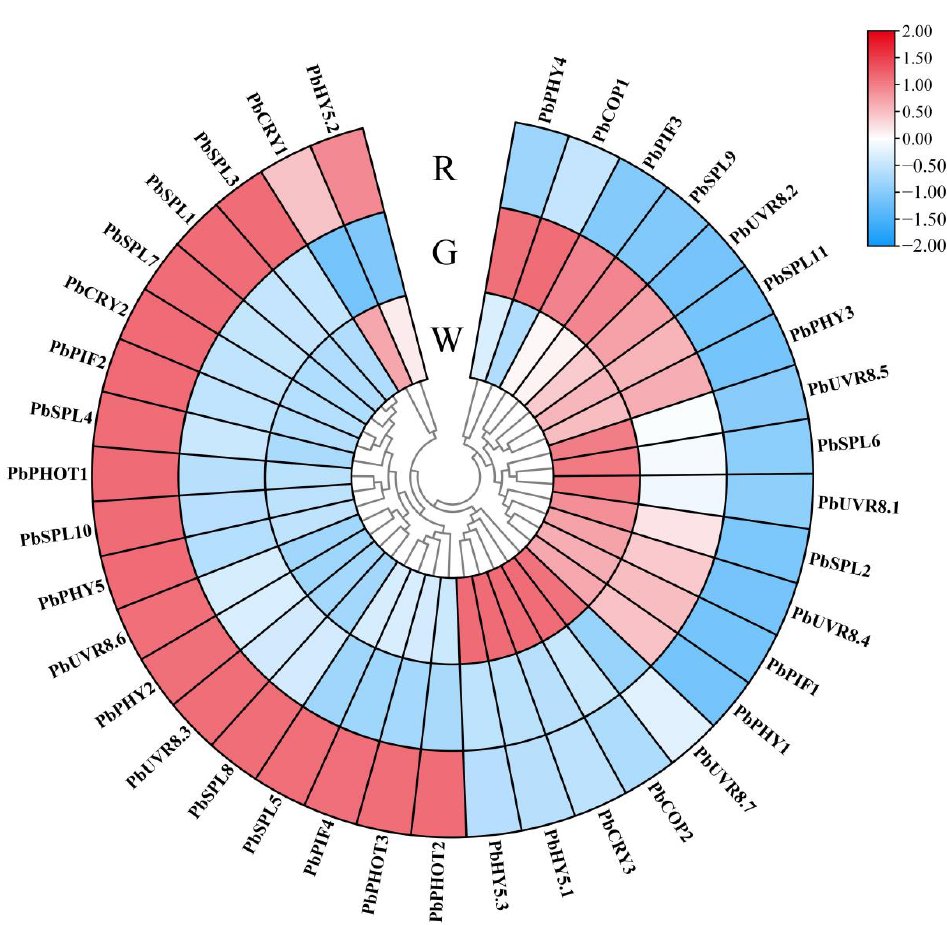
Figure 3. Expression patterns of genes involved in response to the light signal: W: brown–black-bag-treated fruit; G: yellow–white-bag-treated fruit; R: fruit not bagged. Bar: normalized FPKM. The unrooted dendrogram was generated by hierarchical clustering.